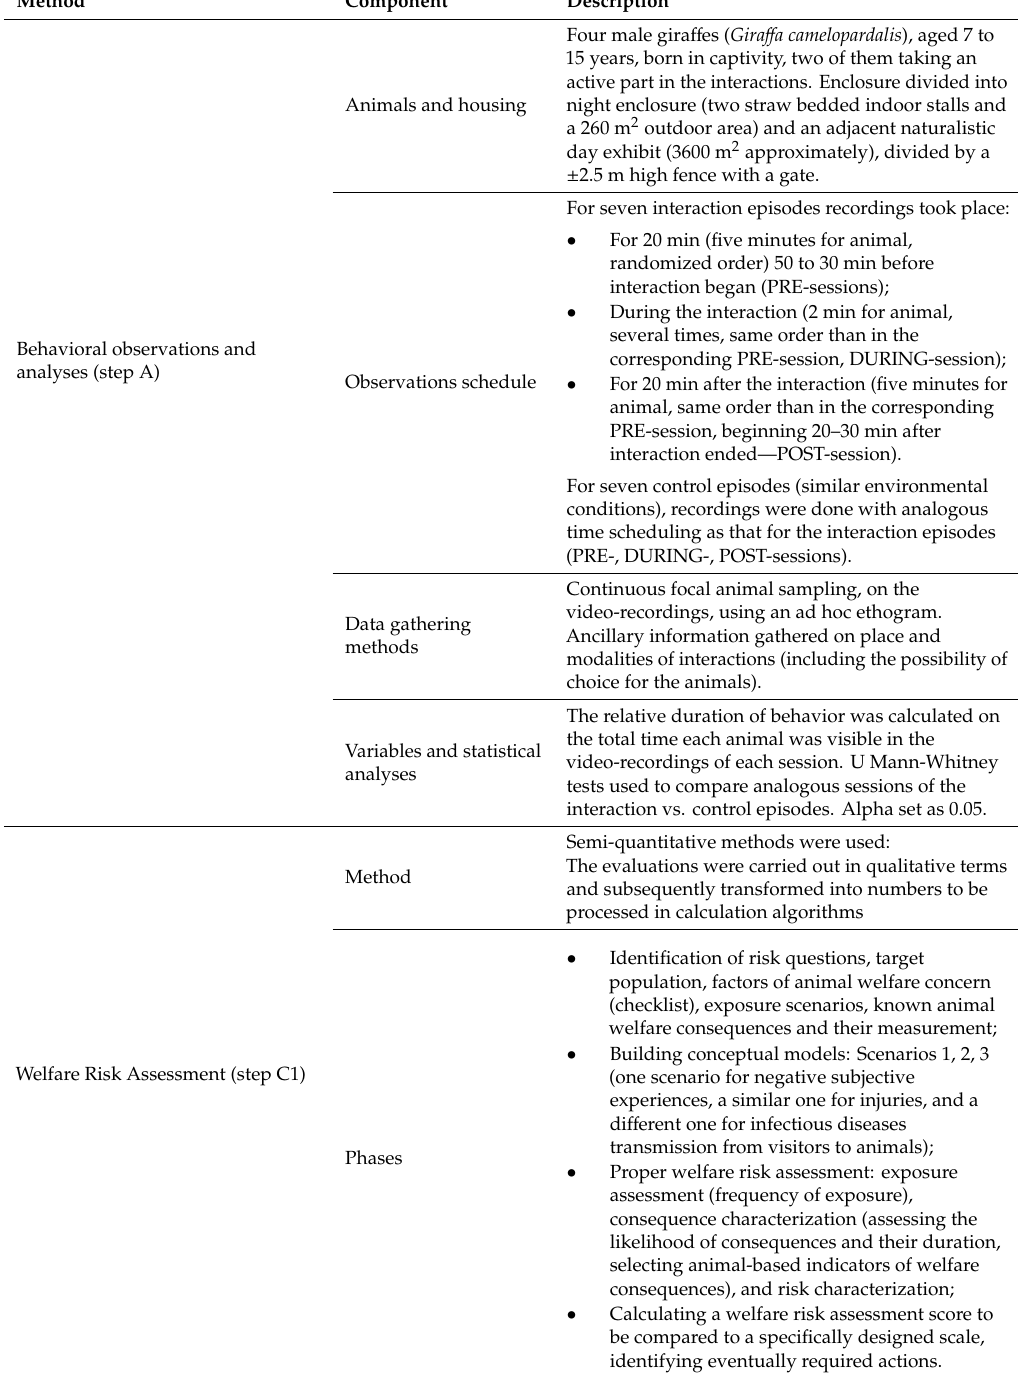
Table A1. Details of the multi-facetted animal welfare assessment used in the pilot study (step